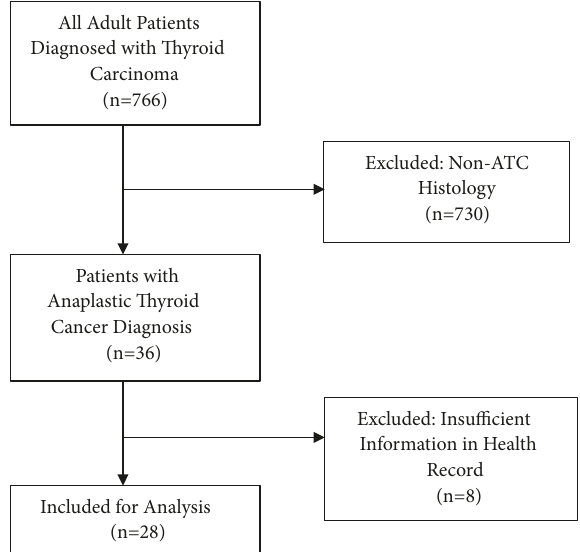
Figure 1: Inclusion